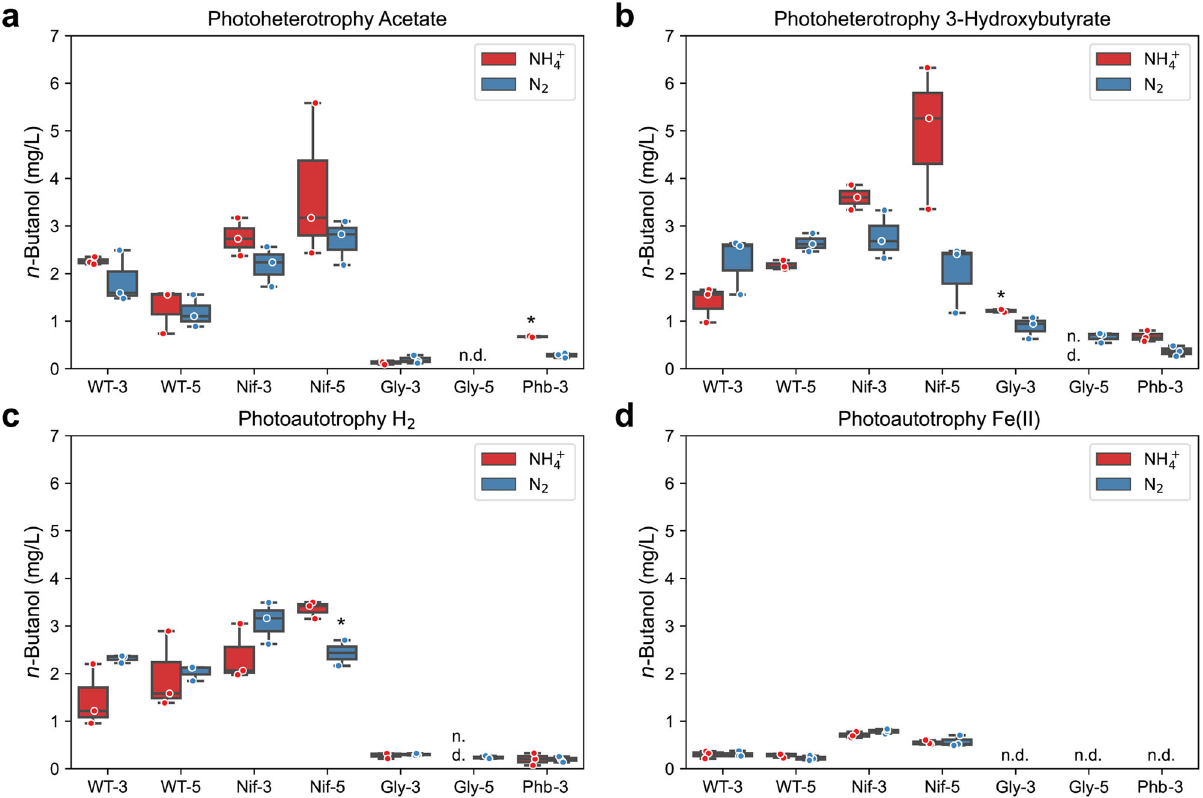
Fig. 2 The nitrogenase double mutant (Nif) produced the highest amount of n -butanol in the presence of 3-hydroxybutyrate. The concentration of n -butanol in mg/L when TIE-1 was cultured with ammonium (NH 4 + , red) or dinitrogen gas (N 2 , blue) and a acetate (photoheterotrophy) b 3-hydroxybutyrate (photoheterotrophy) c hydrogen (H 2 ) (photoautotrophy) and d ferrous iron [Fe(II)] (photoautotrophy). CO 2 was present in all conditions. Data are from n = 3 of independent experiments. Boxes that only have two biological replicates are indicated by ‘ * ‘ . WT-3: wild type with 3-gene cassette; WT-5: wild type with 5-gene cassette; Nif- 3: nitrogenase knockout t with 3-gene cassette; Nif - 5: nitrogenase knockout with 5-gene cassette; Gly- 3: glycogen synthase knockout with 3-gene cassette; Gly- 5: glycogen synthase knockout with 5-gene cassette; Phb- 3: hydroxybutyrate polymerase knockout with 3-gene cassette, n.d.